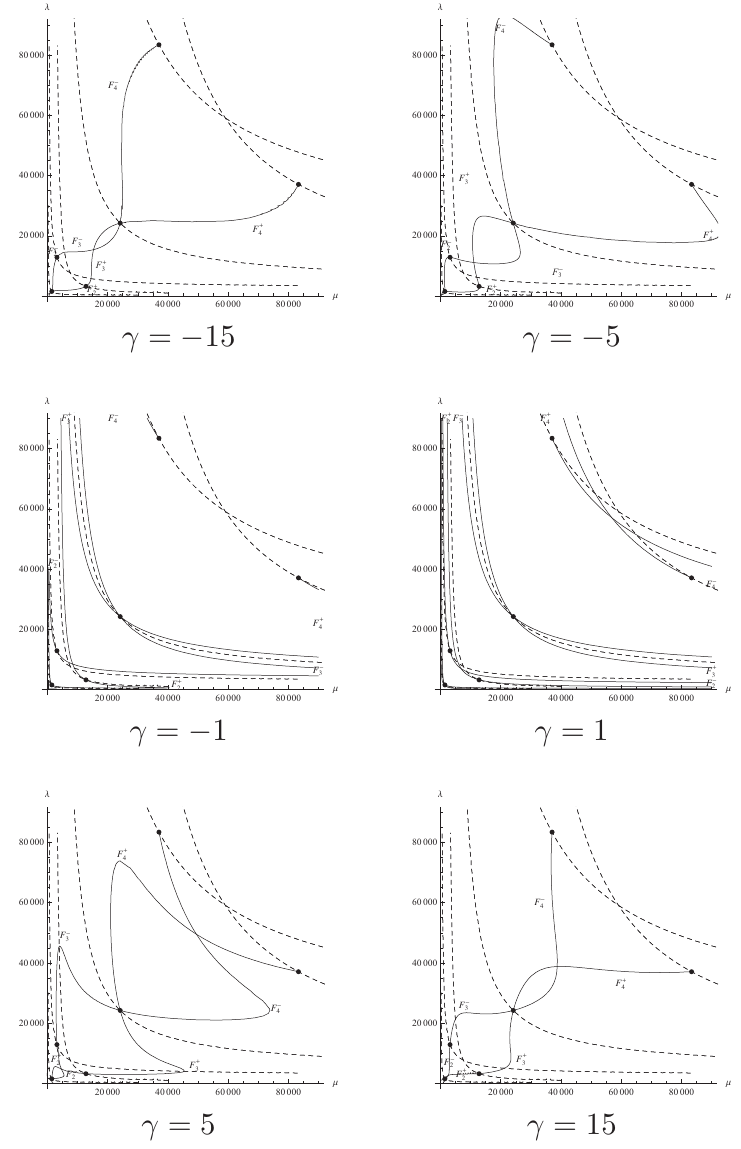
Figure 3. The spectrum for the problem (1.5), (4.1) for different γ